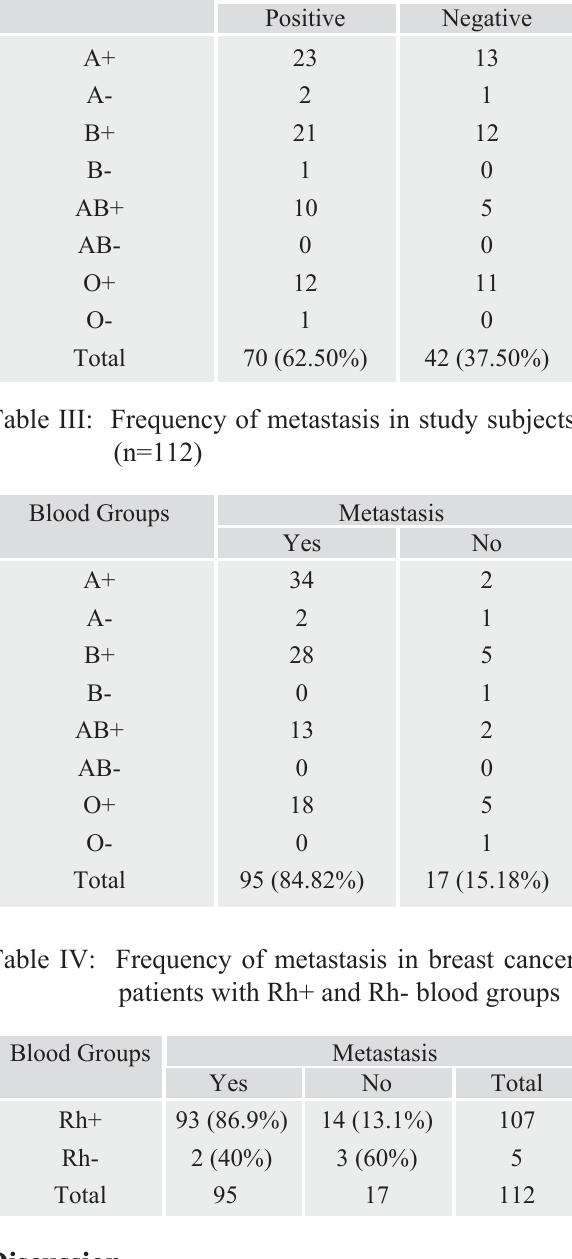
Table II: Family history of breast cancer patients Blood Groups